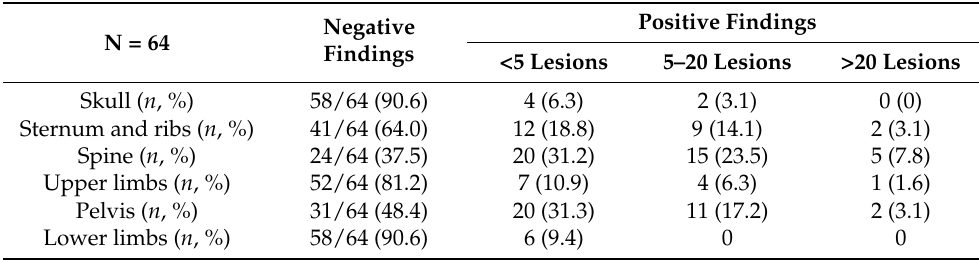
Table 3. Lesions’ distribution according to anatomical district and number. The most commonly involved anatomic district was the spine, followed by pelvis and sternum, and ribs.